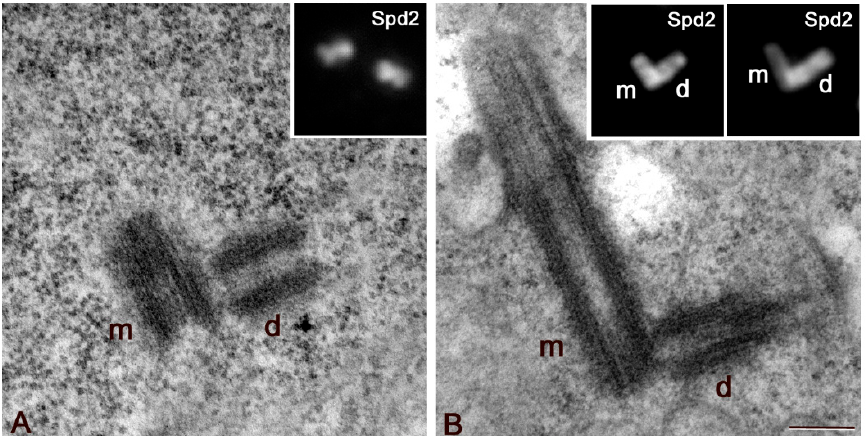
Figure 1. Centriole growth in primary spermatocytes. Ultrastructural details of centrioles in early ( A ) and mature ( B ) primary spermatocytes showing that the daughter centriole (d) lies orthogonal to the proximal end of its mother (m). This orthogonal disposition is not obvious in immunofluorescence analysis of early spermatocytes (( A ), inset), but becomes apparent when the centrioles elongate (( B ), insets). m and d, mother and daughter centrioles, respectively. Scale bar: ( A , B ), 200 nm; insets, 1 μ m.